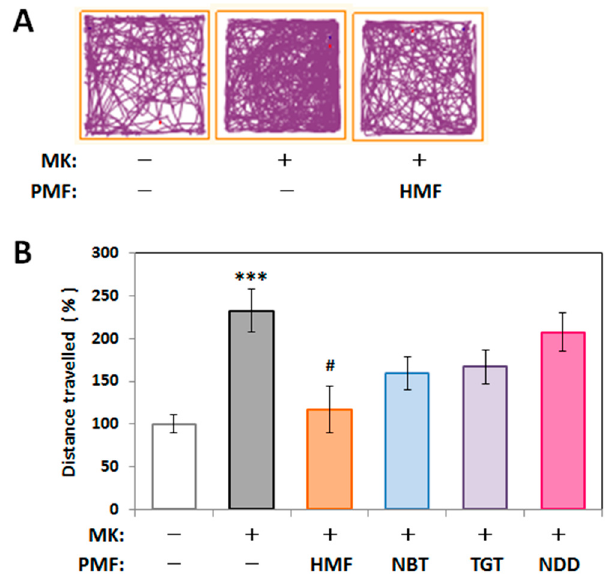
Figure 6. Effect of PMFs on the spontaneous locomotive behavior of MK-801-injected mice in the open field test. ( A ) Representative traces during 10 min; ( B ) Total distance traveled in the open field test during the 10-min period. Values (% control) are the means ± SEM. *** p < 0.001 vs. control group. # p < 0.05 vs. MK group.